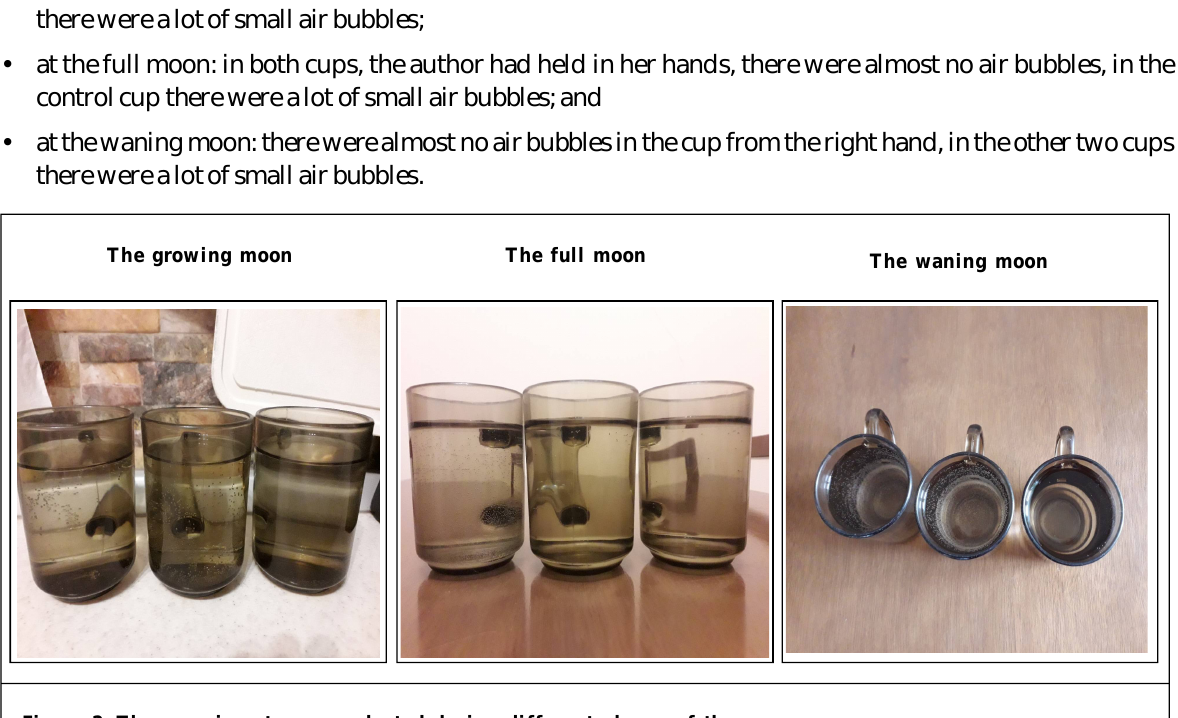
Figure 2: The experiment was conducted during different phases of the moon